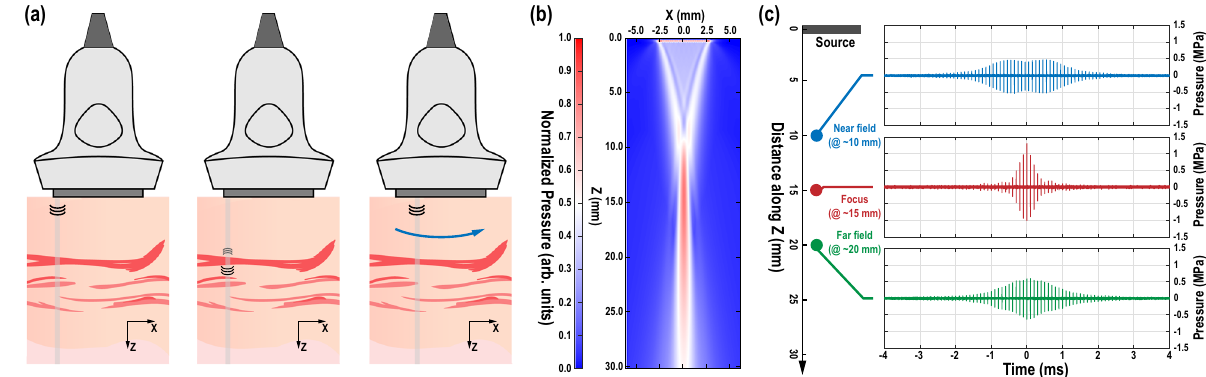
Fig. 2 Principles of ultrasonography. a Illustration of the pulse-echo imaging principle; b a simulated beam pro fi le using a linear array transducer; and c measured pulse envelope at different distances from the source